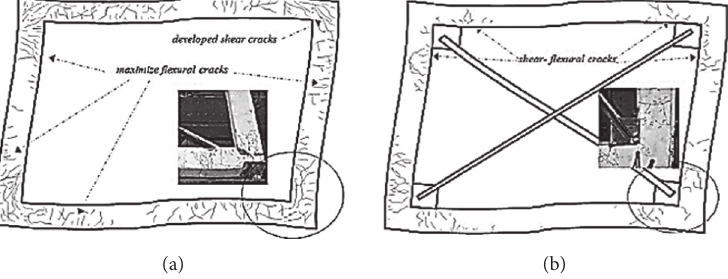
Figure 7: Cracks developed in a reinforced concrete panel with a bracing [27].